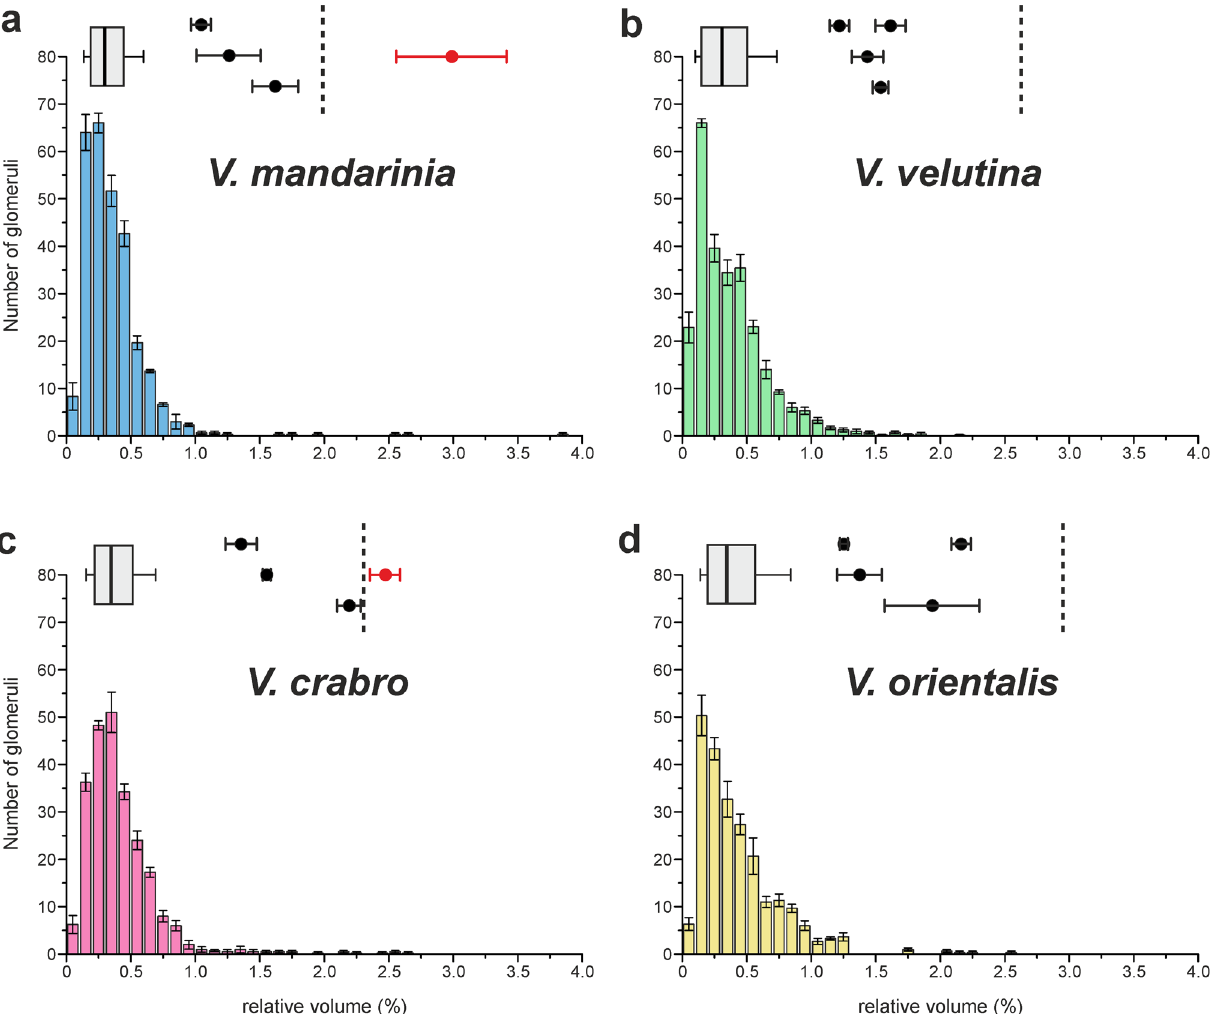
Figure 4. Distribution of glomerular volumes in four hornet species. Distribution of all glomerular volumes in the reconstructed antennal lobes of V. mandarina ( a , n = 3), V. velutina ( b , n = 7), V. crabro ( c , n = 4) and V. orientalis ( d , n = 3). The box plots above each distribution show the median and interquartile range (25–75%) of glomerular volumes whereas whiskers show the 10th and 90th percentiles. The average volumes of the four largest glomeruli of each species are shown with black circles and the statistical macroglomerulus threshold is represented by a dotted line. Only the antennal lobes of V. mandarinia ( a ) and V. crabro ( c ) contain a glomerulus that exceeds this threshold. This macroglomerulus is represented with a red circle (labeled MG in Fig.